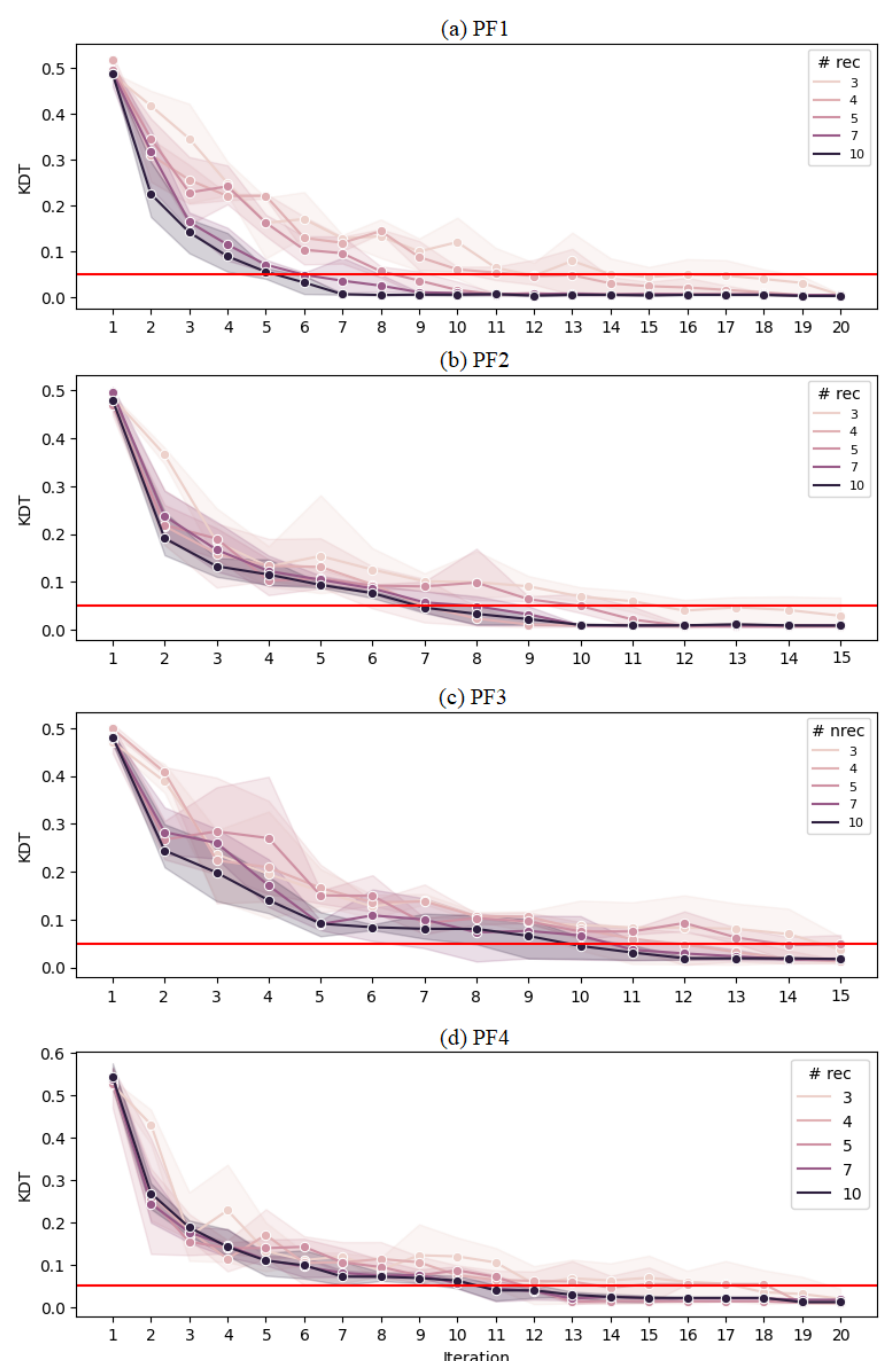
Figure 5. Learning rate for q = [ 3,4,5,7,10 ] alternatives selected at a time for PF1 in ( a ), PF2 in ( b ), PF3 in ( c ), and PF4 in ( d